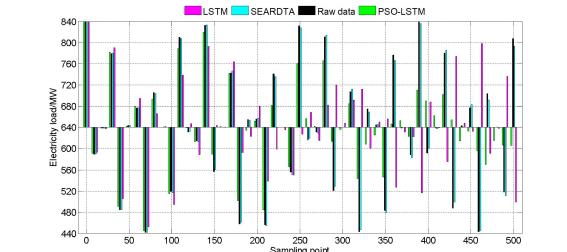
Fig. 7. Histogram of power load forecasting results of different